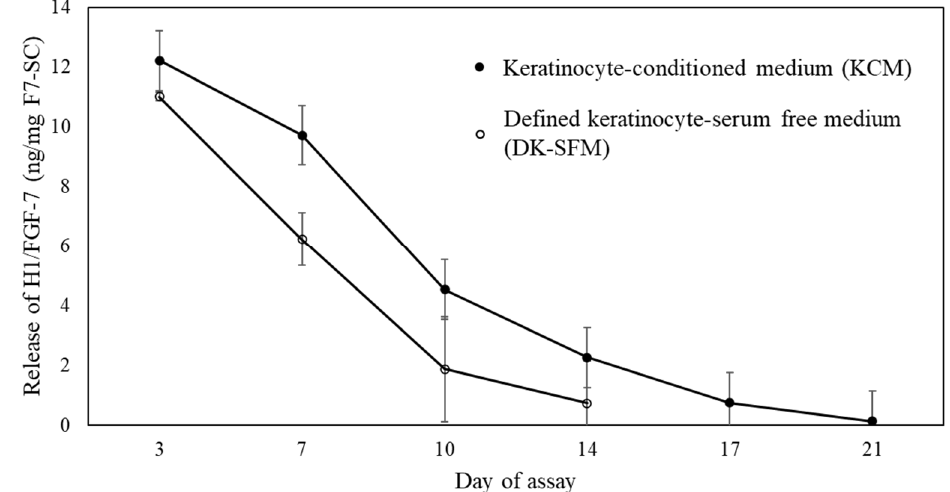
Figure 3. Release profile of H1/FGF-7 from F7-SC powder suspended in aqueous media. Powder of F7-SC was added into keratinocyte-conditioned medium (KCM; •) and DK-SFM ( ◦ ) at 0.04% ( w / v ) and incubated at 37 °C. Media were replaced at the indicated time points, and the amount of H1/FGF-7 released into the collected media was measured using the ELISA. Data are shown as means ± standard deviations (SDs) of triplicate assays.